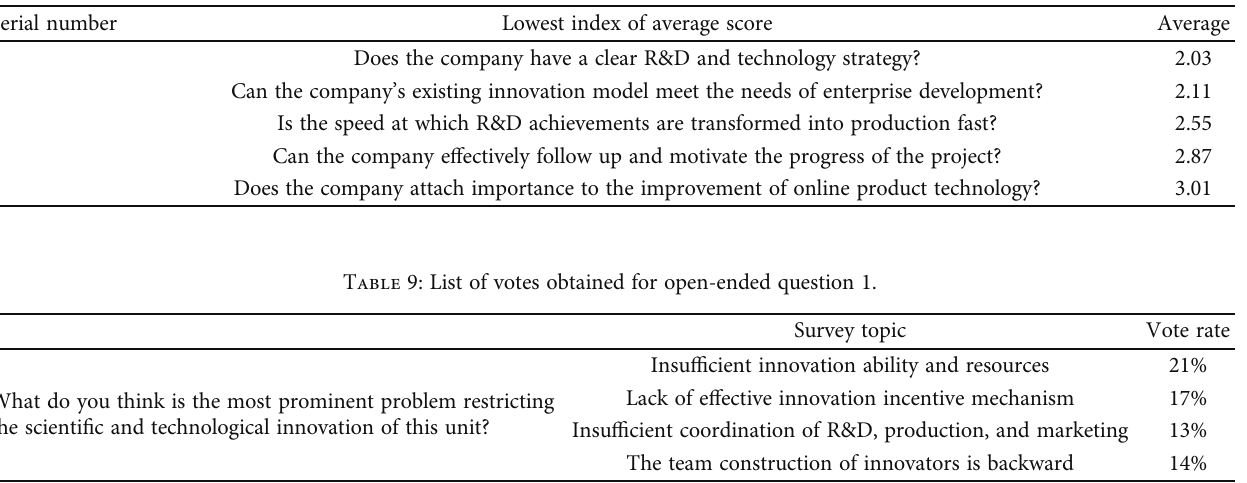
Table 8: Indicators with the lowest average score.